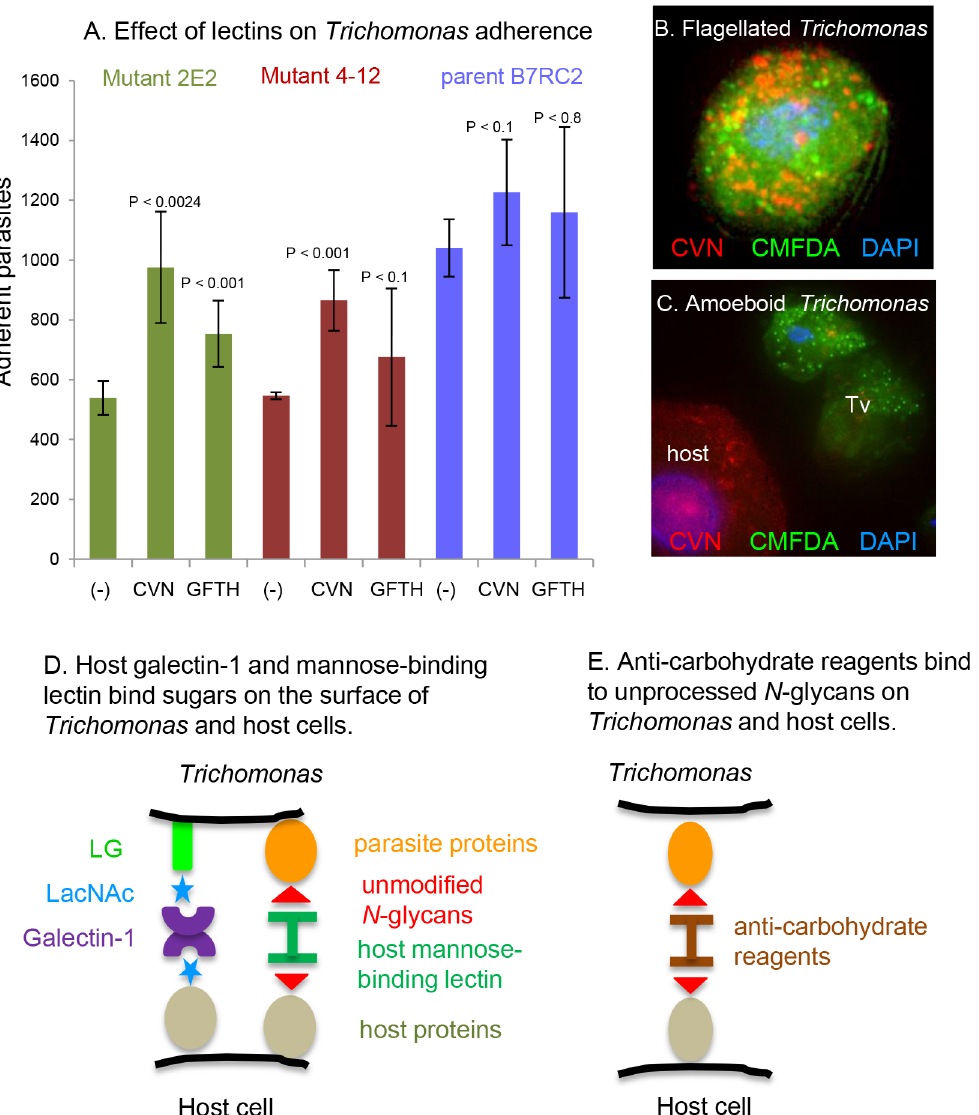
Fig 4. Anti-retroviral lectins increase the adherence of ricin-resistant Trichomonas mutants to ectocervical cells, while cyanovirin-N is lost from the parasite surface when Trichomonas binds to EpiVaginal tissue cells and converts into an ameboid form. A. Cyanovirin-N (CVN) increases the adherence of ricin-resistant mutant Trichomonas (2E2 and 4 – 12) to ectocervical cells in vitro , while griffithsin (GRFT) has less effect. Neither lectin has much effect on the parent B7RC2 strain, which is much more adherent to ectocervical cells in the absence of lectin. Data is average of three experiments. B. A flagellated Trichomonas labeled green with CMFDA (green), which concentrates in secretory vesicles, has cyanovirin-N (red) on its surface. C. When CMFDA-labeled Trichomonas adhere to organotypic EpiVaginal tissue cells, most of the cyanovirin-N is lost. Note that the host EpiVaginal cell (lower left) binds cyanovirin-N. D. A model for how host lectins affect adherence of Trichomonas to host cells is based upon experiments here and previously published experiments [24]. Galectin-1 (purple) secreted by the host epithelial cells cross-links LacNAc residues (bright blue) present on glycans of host proteins (grey) and on parasite LG (bright green). Similarly, host mannose-binding lectin (deep green) cross-links unmodified N -glycans (red) present on host and parasite proteins. E. Exogenous anti-retroviral lectins (brown) cross-link N -glycans on the surface of Trichomonas and host cells.